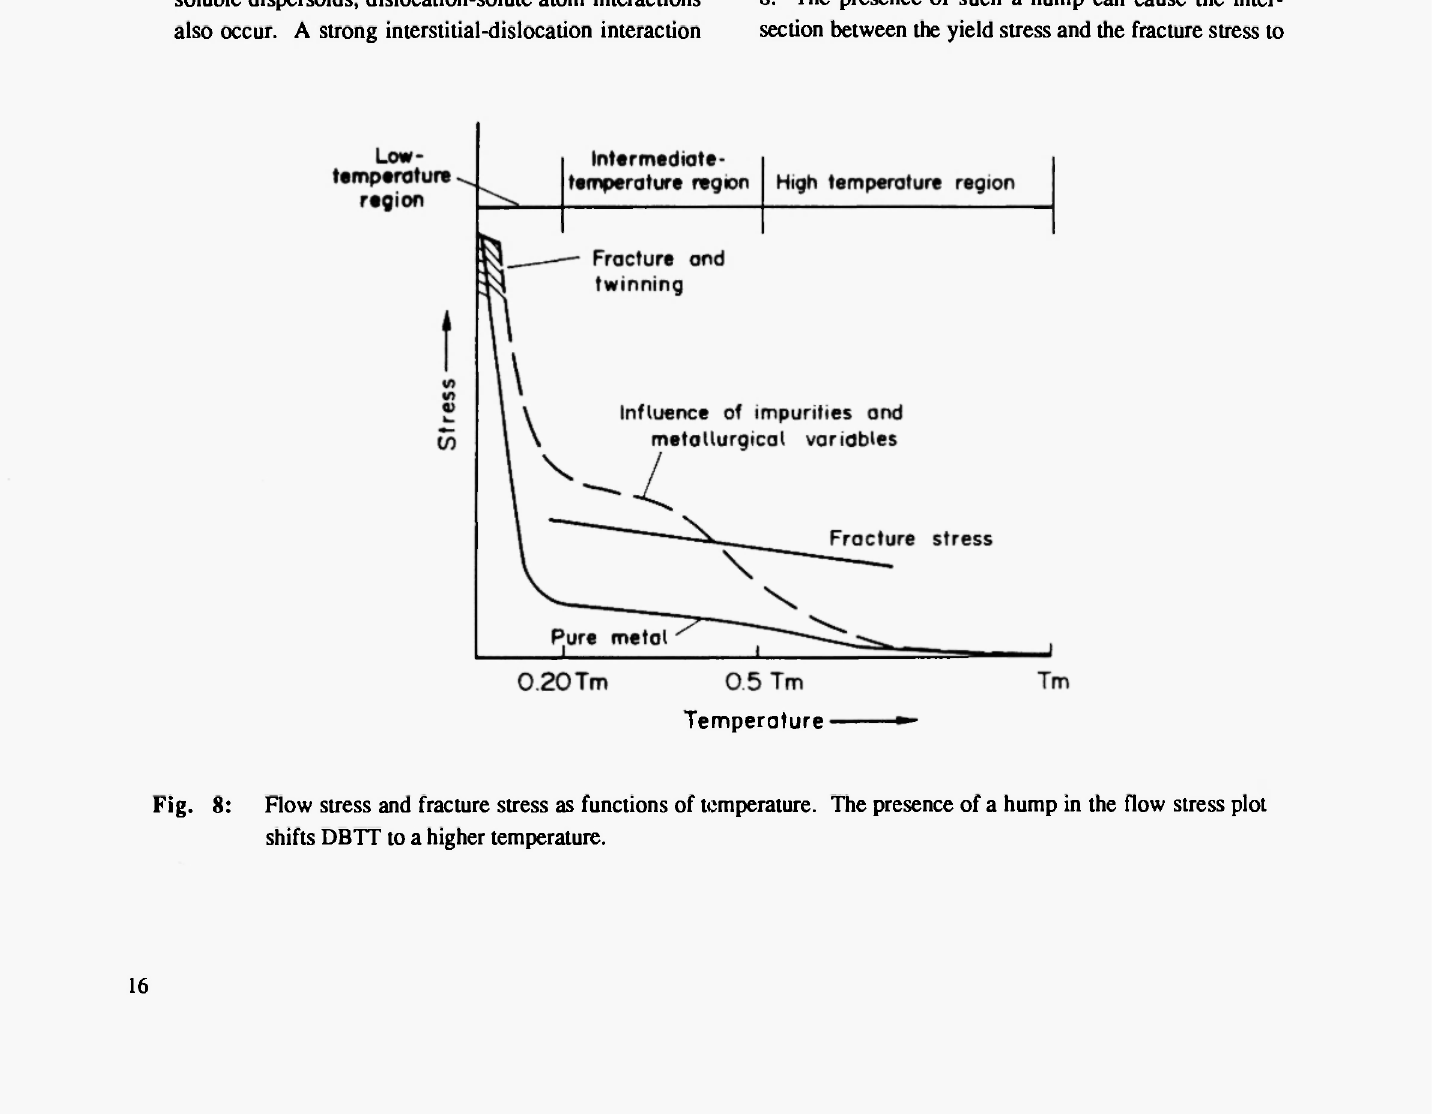
Fig. 8: Flow stress and fracture stress as functions of temperature. The presence of a hump in the flow stress plot shifts DBTT to a higher